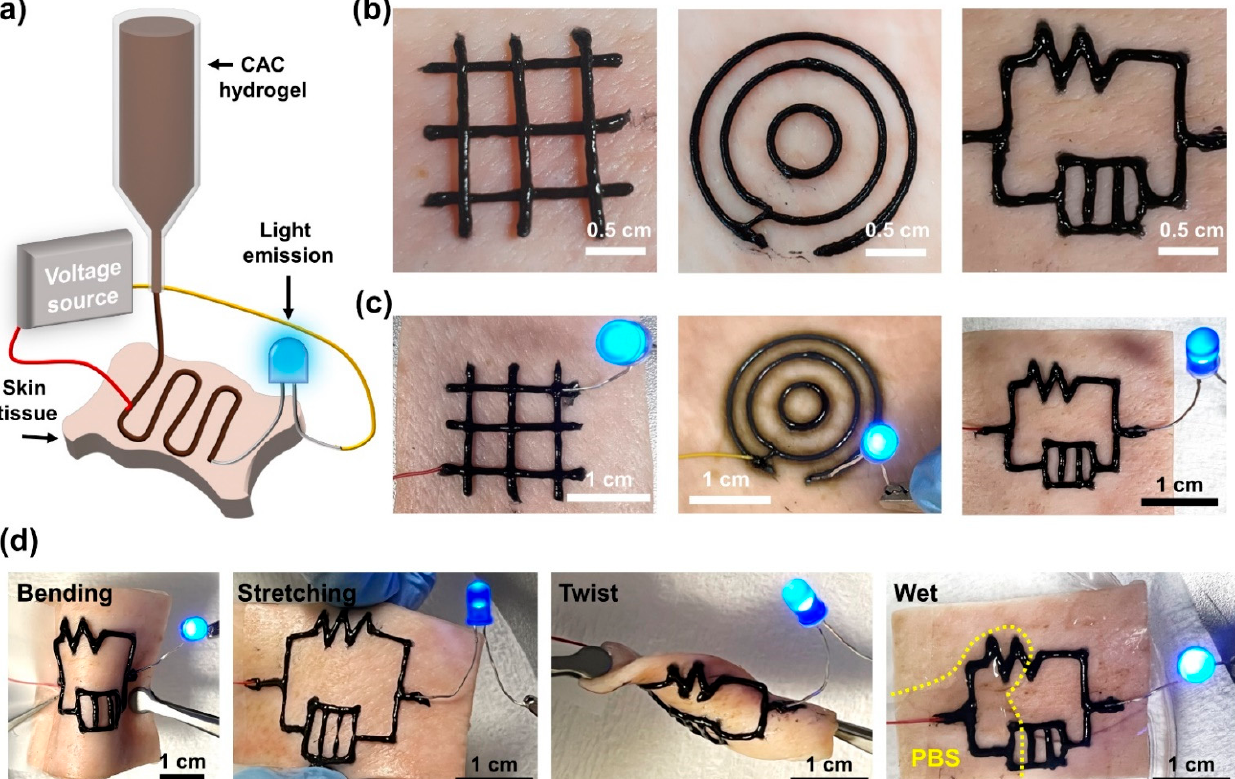
Figure 6. Evaluation of electronics directly printed on tissue with the CAC hydrogel. ( a ) Schematic of the direct-printing process. ( b ) Macroscopic images of concentric ( left ), grid ( middle ), and circuit- shaped ( right ) electronics printed using the CAC Au hydrogel. ( c ) Photographs of LED emission with printed electronics. ( d ) LED light emission with a stable conductivity under stretching ( left ) and bending ( right ) deformation.